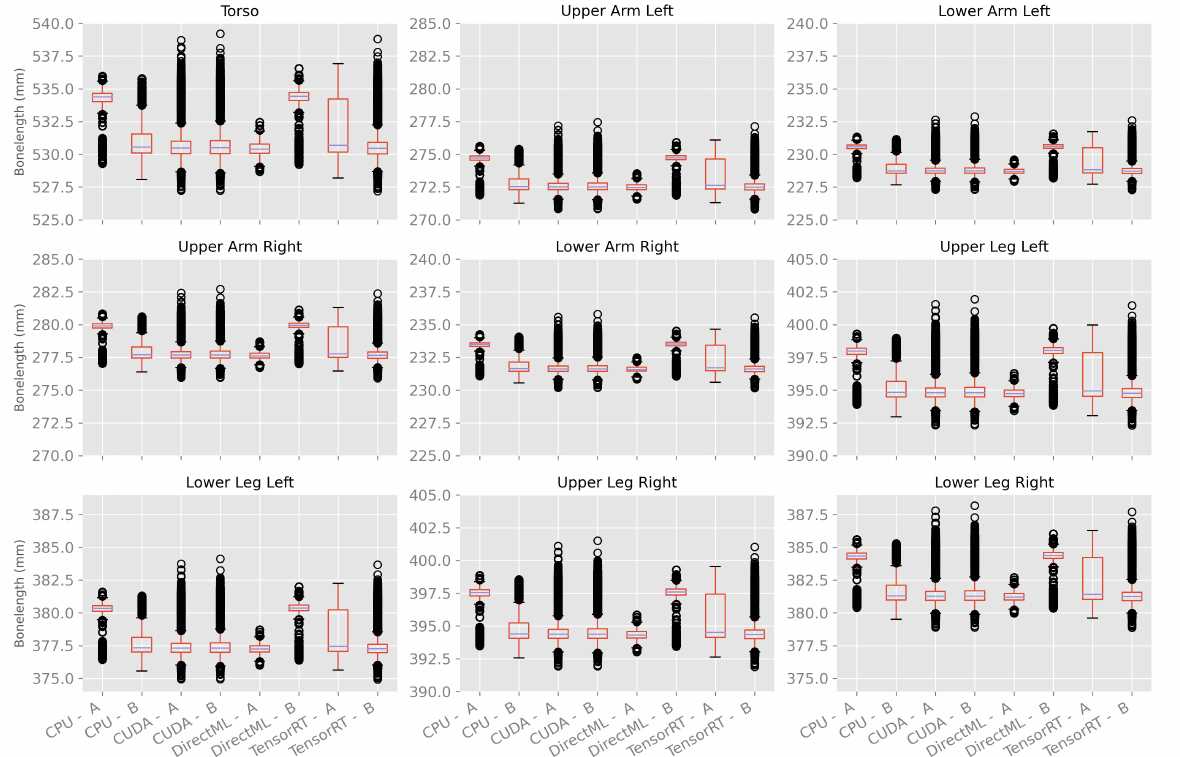
Figure 14. Box plots of bone length using 100 body tracking runs for all four processing modes on computers A and